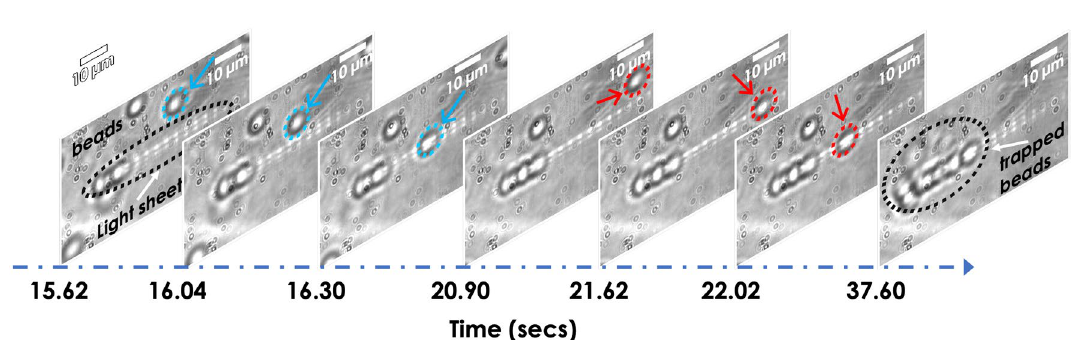
Figure 4. Images taken during the trapping of dielectric beads. Few free beads in close proximity to the light sheet are indicated by blue and red circle/arrow that are eventually trapped in the process. The respective timeline is shown below. The entire process is encapsulated in the Supplementary Video